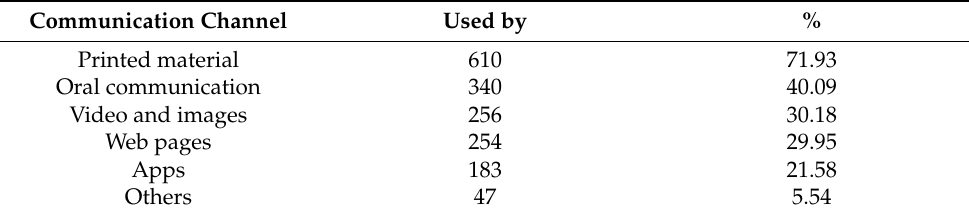
Table 3. Communication channel used to provide additional information.